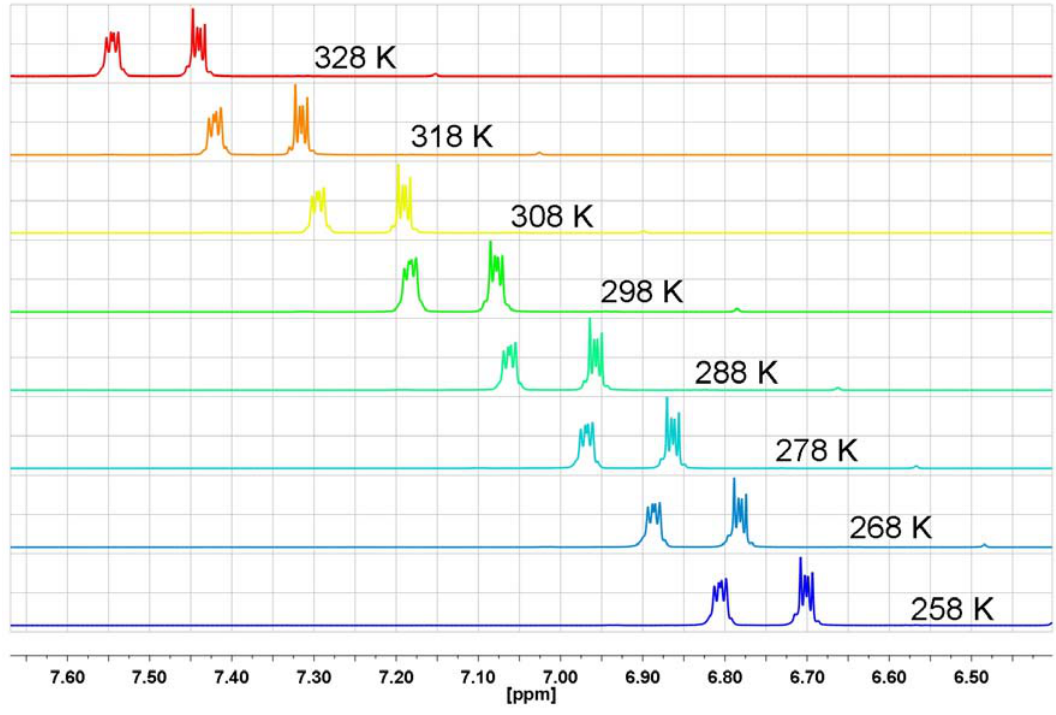
Figure 15. The aromatic proton region of the 1 H-NMR spectrum in CD different